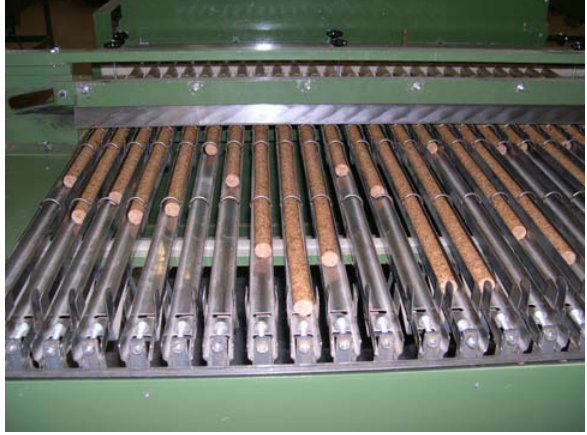
Figure 2. Agglomerated cork baton for agglomerated cork stopper